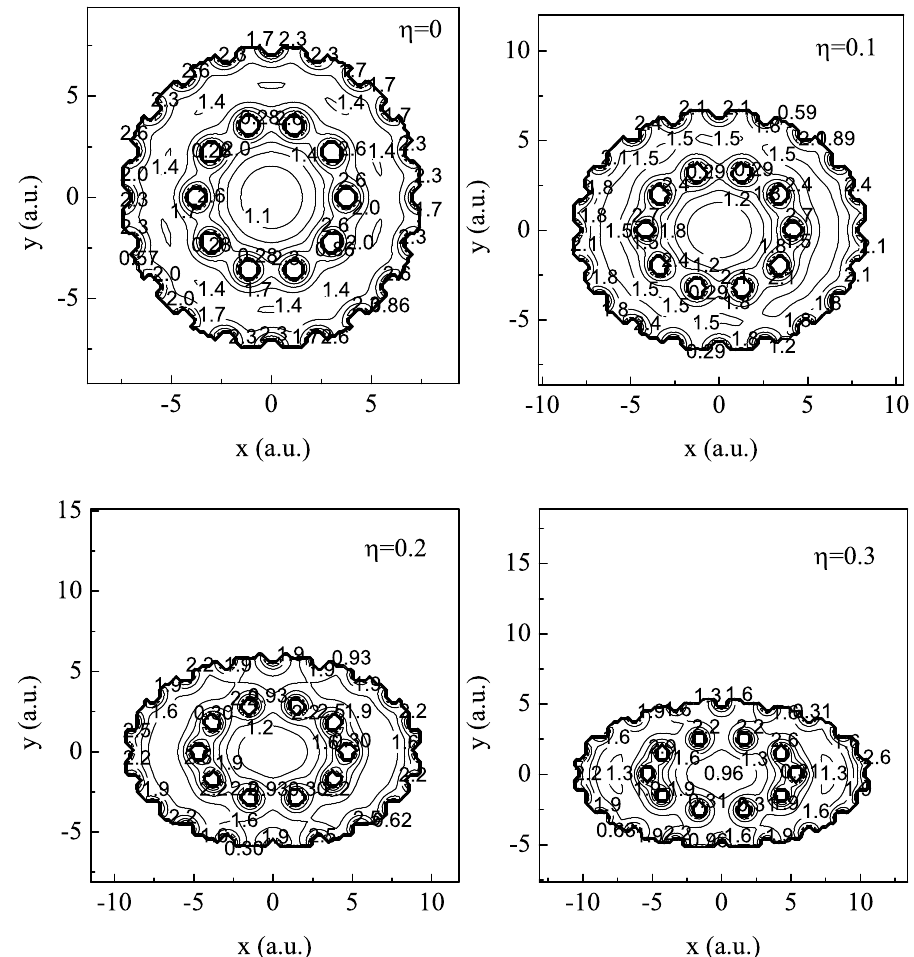
Figure 2. Contour plot of the channeling potential U ( x , y ) in the xy plane of DWNTs(10, 0)@(5, 0) under different radial strains: (left top) η = 0; (right top) η = 0.1; (left down) η = 0.2; (right down) η = 0.3,